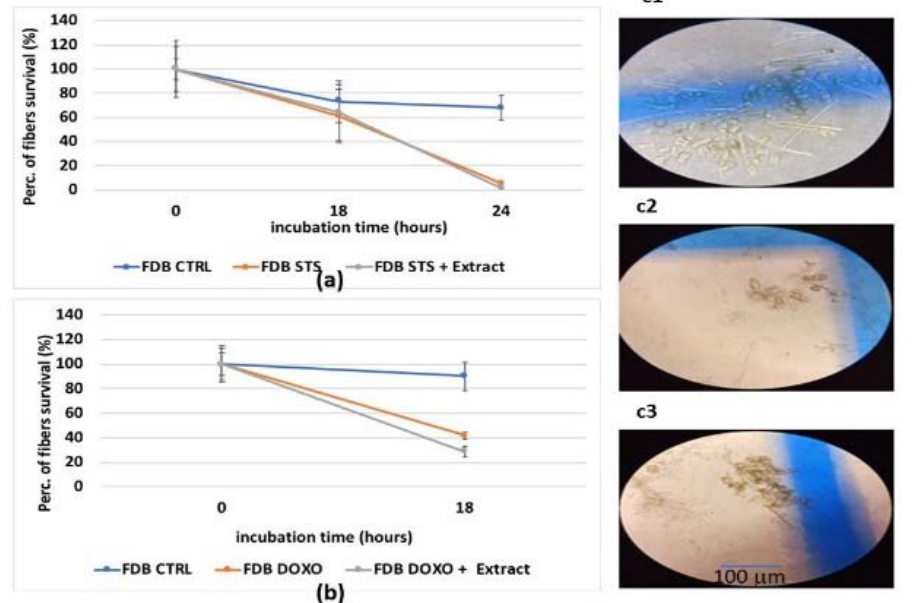
Figure 5. ( a ) Evaluation of FDB fiber survival after an incubation time of 18 and 24 h with staurosporine (STS) (2.14 × 10 − 6 M) and the extract (2.5 mg/mL) (E). ( b ) Evaluation of FDB fiber survival after an incubation time of 18 h with doxorubicin (1 × 10 − 6 M) and extract. Image of FDB fibers ( c1 )